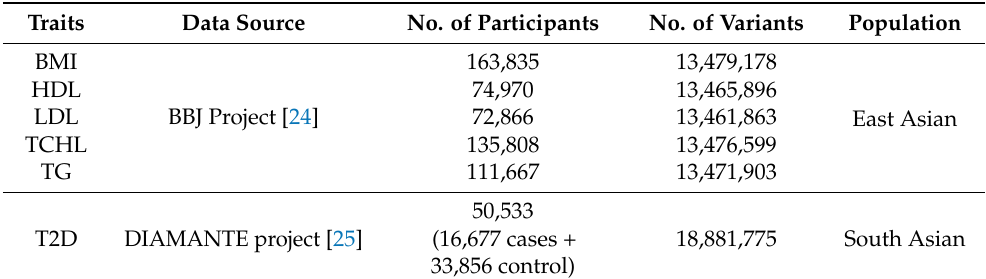
Table 1. Summary statistics of